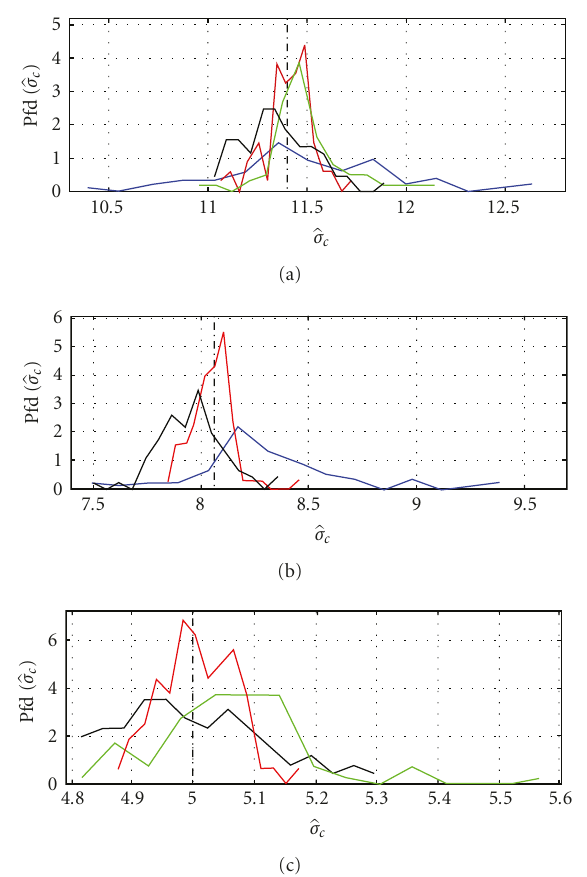
Figure 9: Empirical pdfs of STD estimates (cid:19) σ c obtained for the whole TID2008 database by (1) NI+fBm (in black color); (2) NI+DCT (in red color); (3) BM3D (in green color); (4) SBIQ (in blue color); = 130 (a), σ 2 = 65 (b), and σ 2 = 25 noise variances are equal to σ 2 n 0 n 0 n 0 (c). The true noise STD is marked by dashed vertical line in all plots.